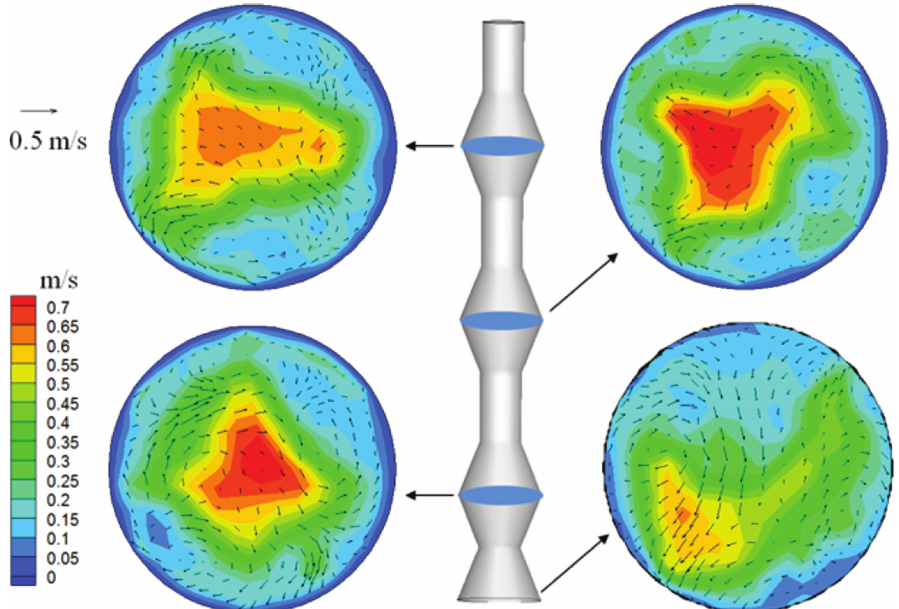
Figure 5: Velocity vector and contour profiles in the transversal sections of the three chambers and the outlet.